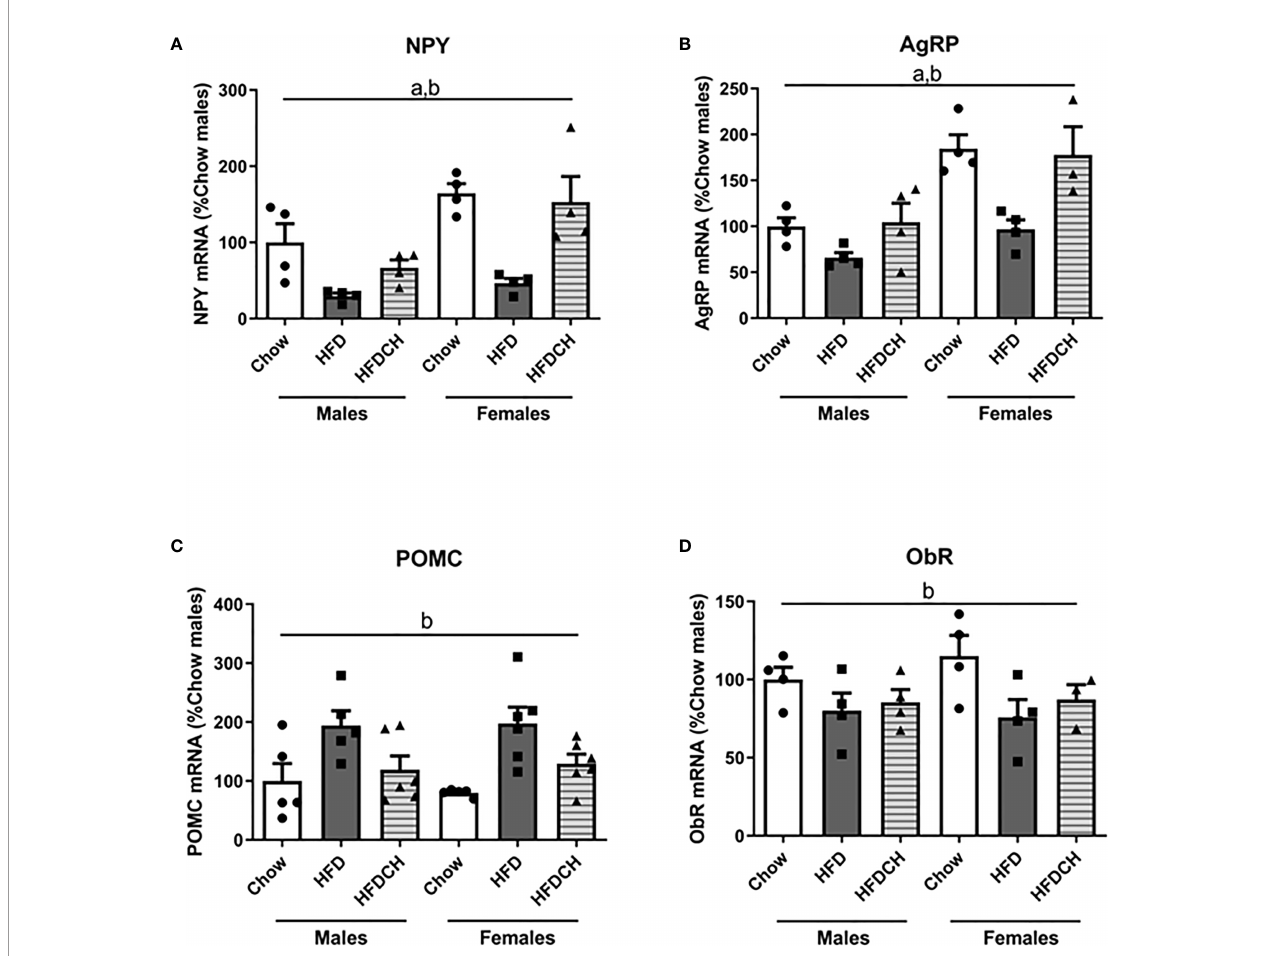
FIGURE 5 | Relative mRNA levels of orexigenic and anorexigenic neuropeptides in the hypothalamus. Neuropeptide Y [NPY; (A) ], Agouti-related protein [AgRP; (B) ], and proopiomelanocortin [POMC; (C) ], as well as leptin receptor [ObR; (D) ] in mice fed chow or a high-fat diet (HFD) for 12 weeks or HFD for 8 weeks followed by chow for 4 weeks (HFDCH) 4 weeks. a, effect of the sex; b, effect of the diet. n = 4 -